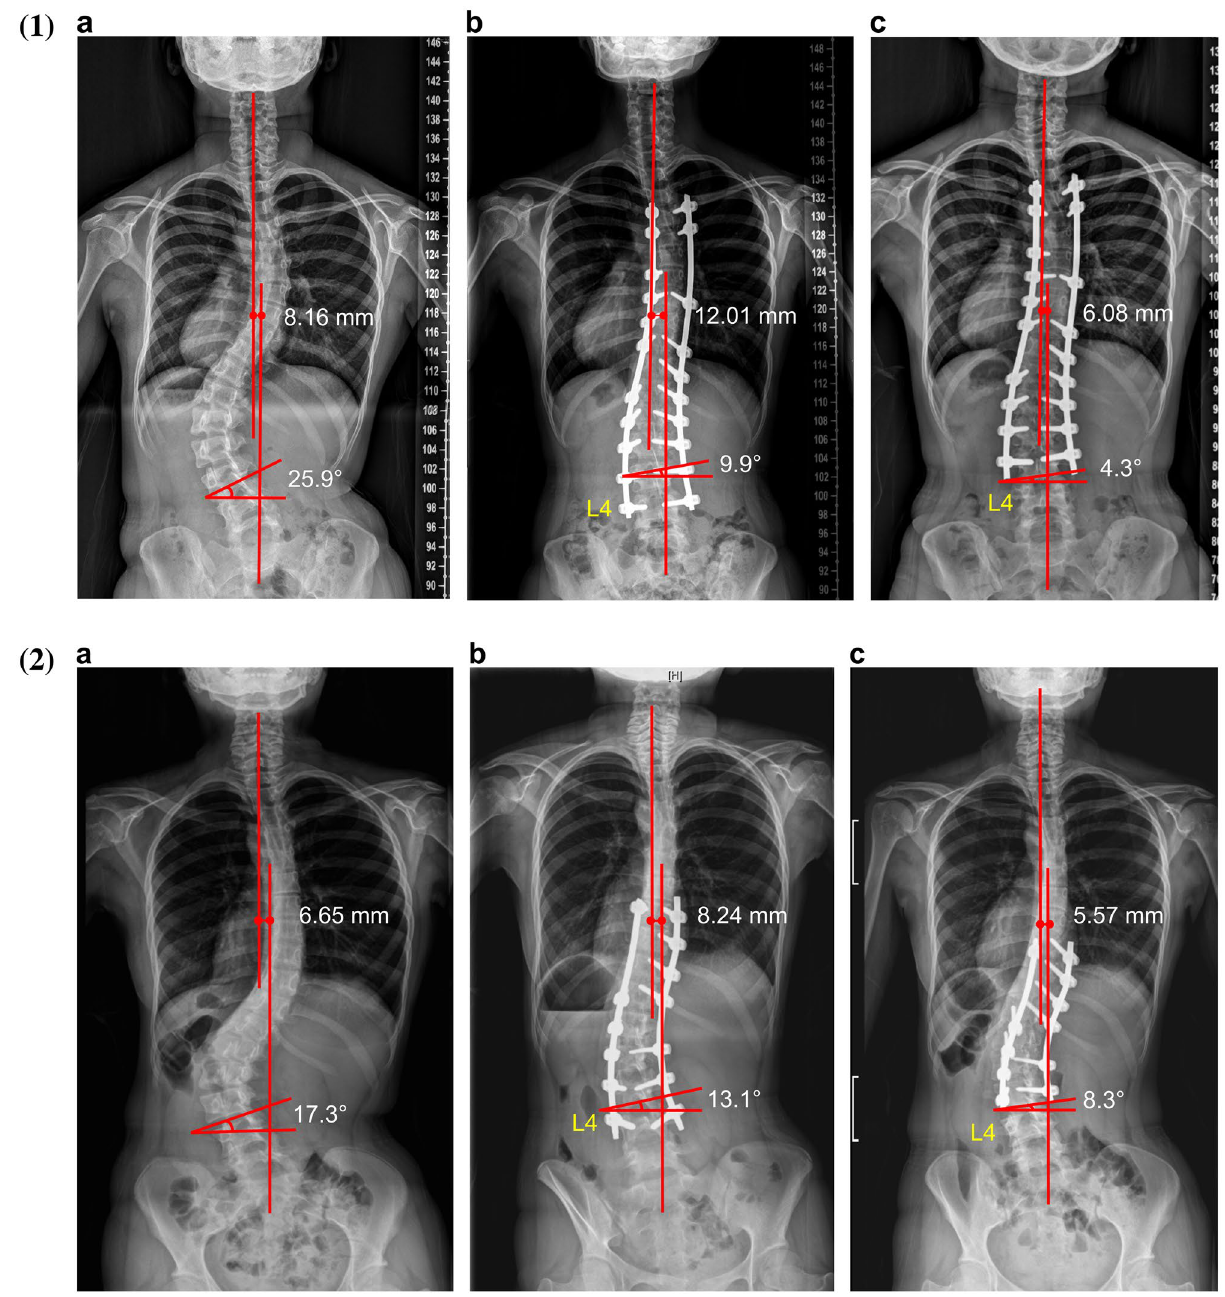
Figure 3. (1) Serial whole spine standing X-ray images, representing a 16-year-old Lenke Type 6C patient ( a ) Preoperative LIV (L3) tilt angle is 25.9°, and the L3 displays a second-degree Nash-Moe rotation. Coronal balance is 8.16 mm. ( b ) After the first surgery (transient fixation) up to L4, the LIV (L3) tilt angle improves to 9.9 ° , the L3 normal rotation improves, and the coronal balance slightly worsens to 12.01 mm. ( c ) The second surgery (L4 transient screw removal) was performed 6 months after the first surgery. In the final follow-up radiograph (2 years and 3 months after the first surgery), the LIV (L3) tilt angle is 4.3°, L3 normal rotation is maintained, and coronal balance is 6.08 mm. (2) Serial whole spine standing X-ray images, representing a 17-year-old Lenke Type 5C patient ( a ) The preoperative LIV (L3) tilt angle is 17.3°, and the L3 displays a second-degree Nash-Moe rotation. Coronal balance is 6.65 mm. ( b ) After the first surgery (transient fixation up to L4), the LIV (L3) tilt angle improves to 13.1 ° , the L3 normal rotation improves, and the coronal balance slightly worsens to 8.24 mm. ( c ) The second surgery (L4 transient screw removal) was performed 11 months after the first surgery. In the final follow-up radiograph (3 years after the first surgery), after the second surgery, the LIV (L3) tilt angle is 10.3 o , and coronal balance is 5.57